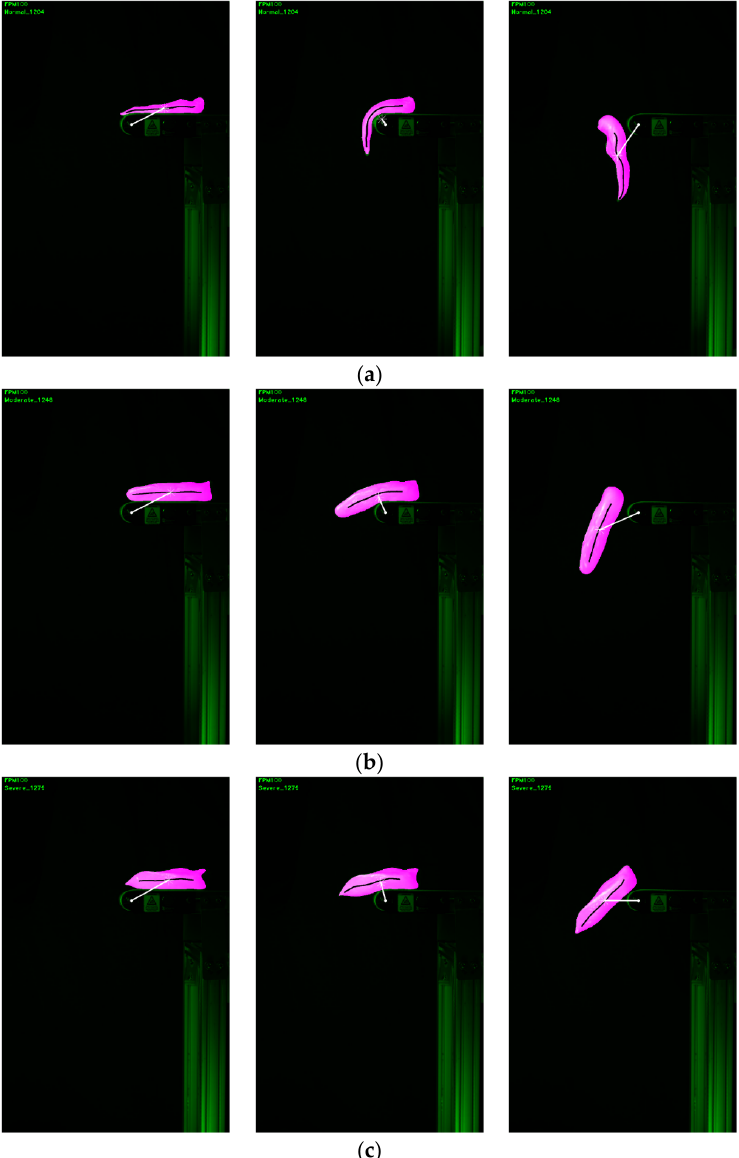
Figure 8. Example images on object segmentation (pink) of ( a ) normal, ( b ) moderate WB, and ( c ) severe WB fillets overlaid with the fillet centroids (white asterisk), center point of rotating axle (white dot), lines (white) connecting the centroid and the center point to calculate a distance, and fillet skeletons (black).